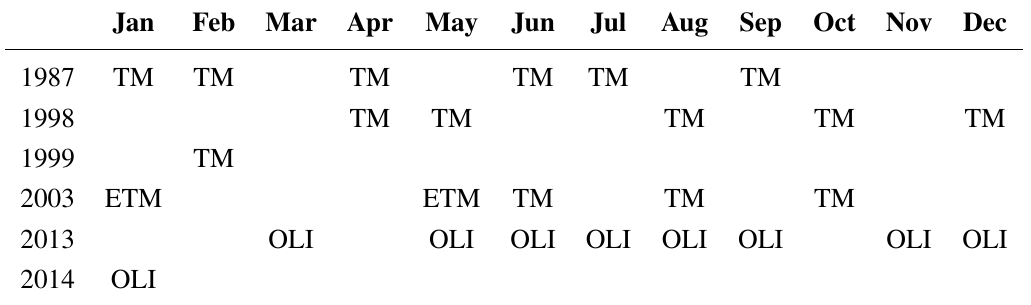
Table 1. Satellite images from the Landsat archive used for the change detection analysis.